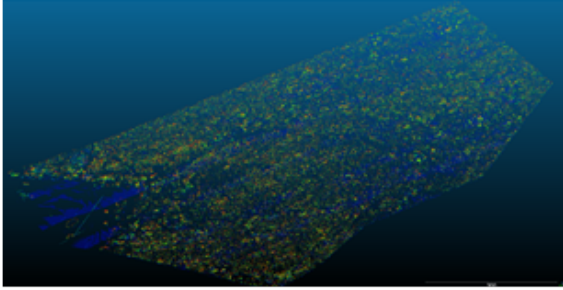
Figure 16: Near-surface fuel at resolution 0.40m.